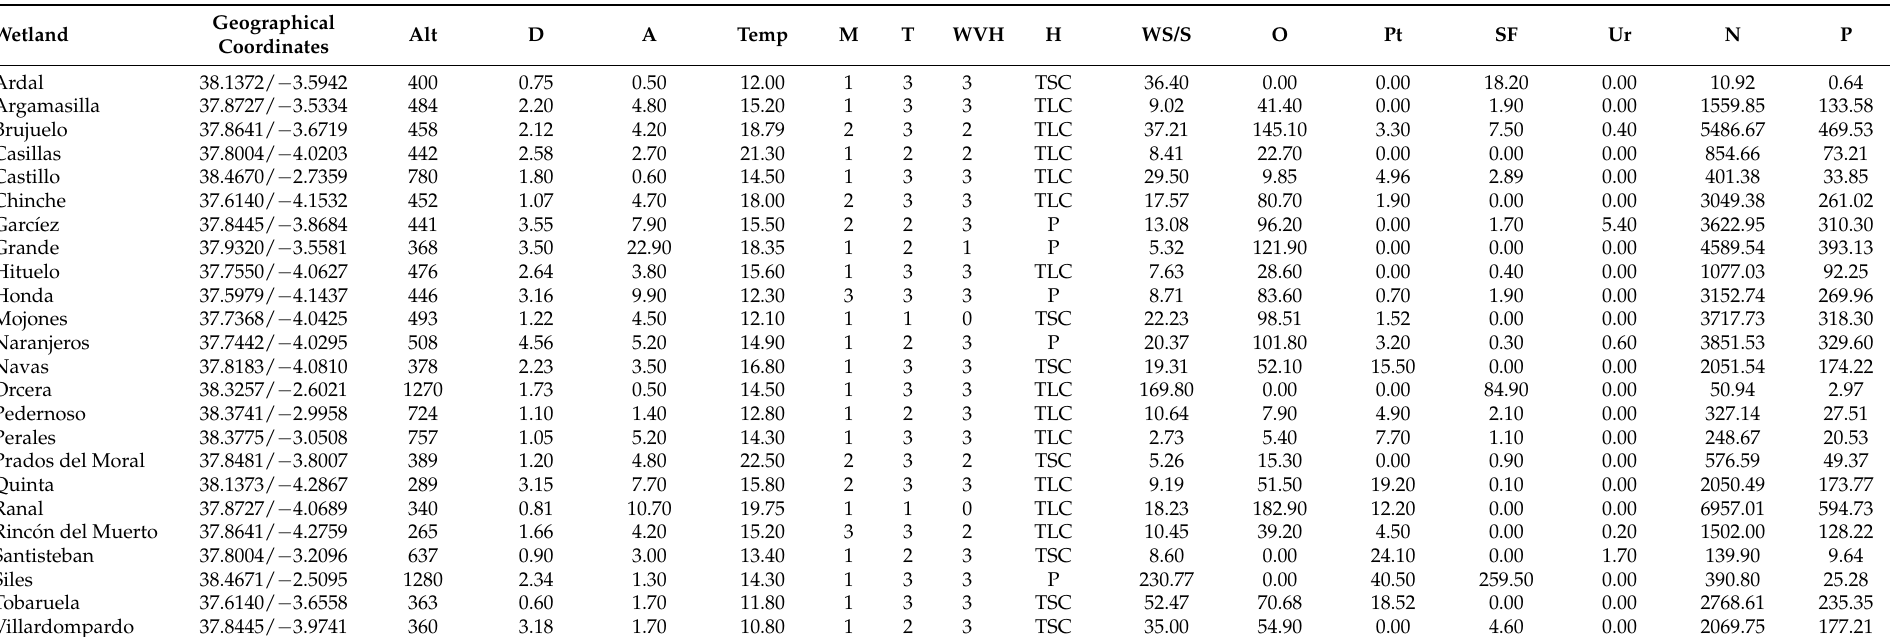
Table 2. Characteristics of the studied wetlands. Alt: altitude (m); D: maximum wetland depth (m); A: wetland surface (ha); Temp: mean annual temperature (ºC); M: water mineralisation—according to Hammer’s classification—(1) freshwater and subsaline waters; (2) hyposaline and mesosaline waters; (3) hypersaline waters; T: water turbidity—(1) turbid waters; (2) semi-transparent waters (3) clear waters; WVH: wetland vegetation heterogeneity—(0) without vegetation; (1) only with shoreline vegetation; (2) only with submerged vegetation; (3) with shoreline and submerged vegetation; H: Hydroperiod length—(1) temporal short cycle (< 5 months); (2) temporal large cycle (> 5 months); (3) permanent; WS/S: watershed surface area: wetland surface area; O: olive tree cultivation (ha); PT: herbaceous crops or/and pasture (ha); SF: scrubland and forest (ha); Ur: urban areas (ha); N: nitrogen enrichment from the activities in watershed; and P: phosphorus enrichment from the activities in watershed. The unit represents kg of nitrogen and phosphorus according to